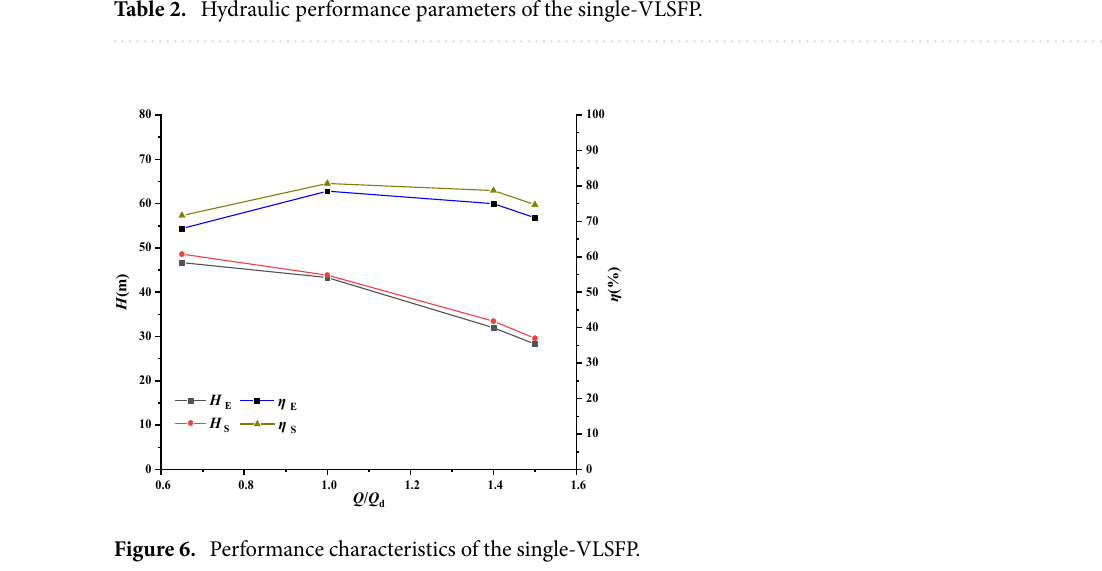
Figure 6. Performance characteristics of the single-VLSFP.